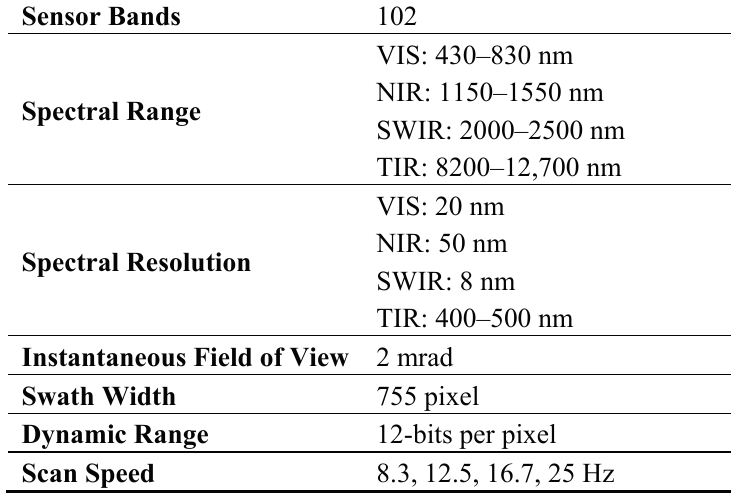
Table 1. Summary of the MIVIS characteristics